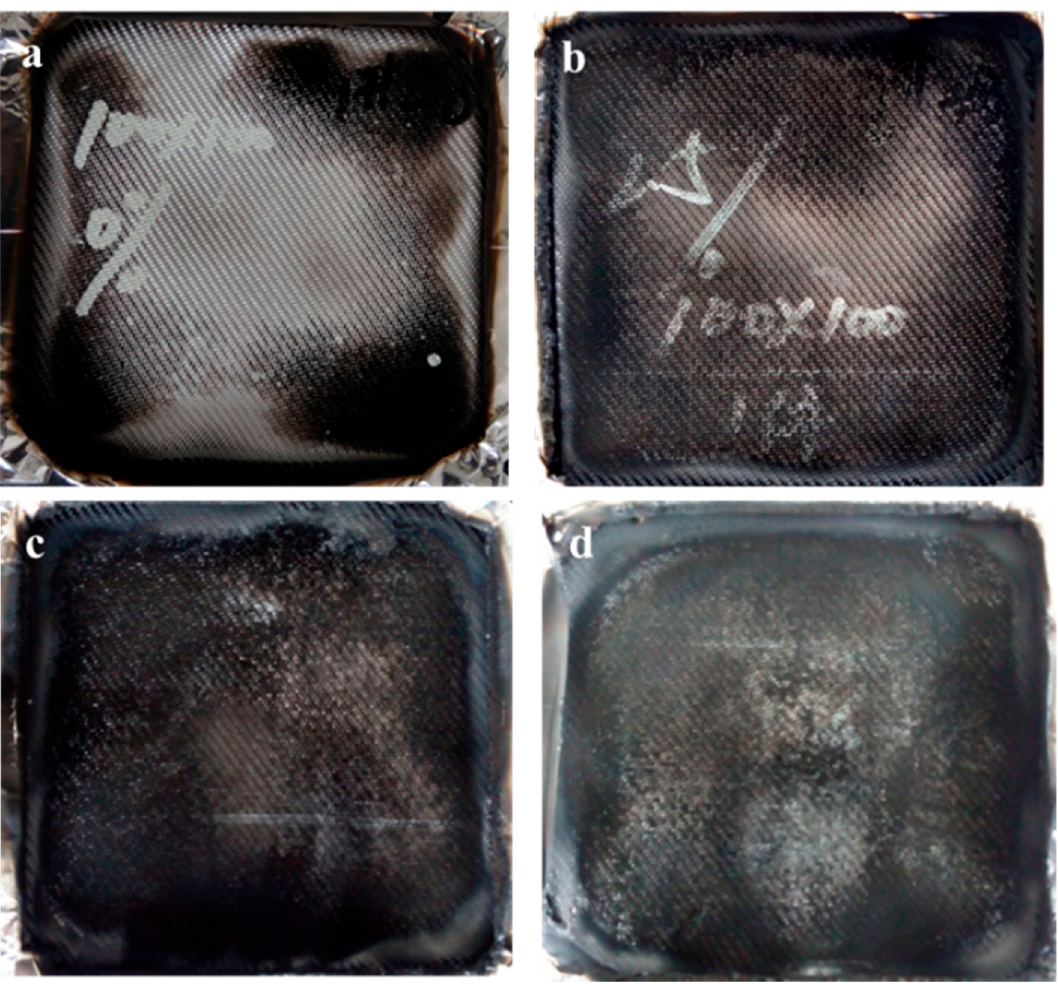
Figure 7. Digital pictures for RTM epoxy composites preformed by ET3228 tackifiers containing ( a ) 0, ( b ) 23, ( c ) 38 and ( d ) 48 wt.% MRP after the cone calorimeter test.